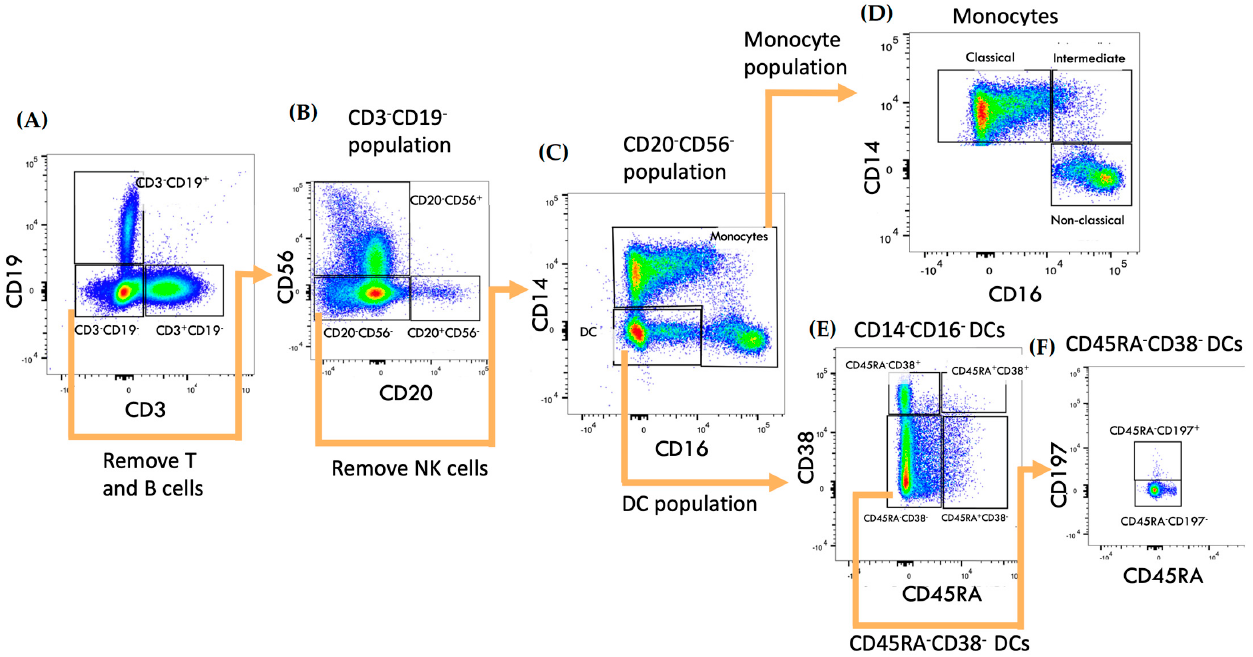
Figure 1. Gating strategy of monocytes and DC subsets. ( A , B ) Lymphocytes were first removed by selecting on CD3 – CD19 − gate, which was then gated on CD56 and CD20. ( C ) Separation of mono–cytes and DCs. ( D ) Classical (CD14 + CD16 – ), intermediate (CD14 + CD16 + ) and non–classical (CD14 dim CD16 + ) monocytes. ( E ) DCs subsets classification. ( F ) Identification of CD38 − CD45RA − CD197 + DCs. The sequence of gating is indicated by the arrows. Fresh PMBCs were obtained from healthy subjects and untreated and oral-cladribine- treated RRMS patients and counted before being added to the transmigration assay. Individual values for each patient were presented in a scatter plot with the median shown (Figure 2). The total PBMC numbers were significantly lower in oral-cladribine-treated than in untreated RRMS patients even months after the treatment (Figure 2A). However, the numbers of total monocytes and DCs did not differ between groups (Figure